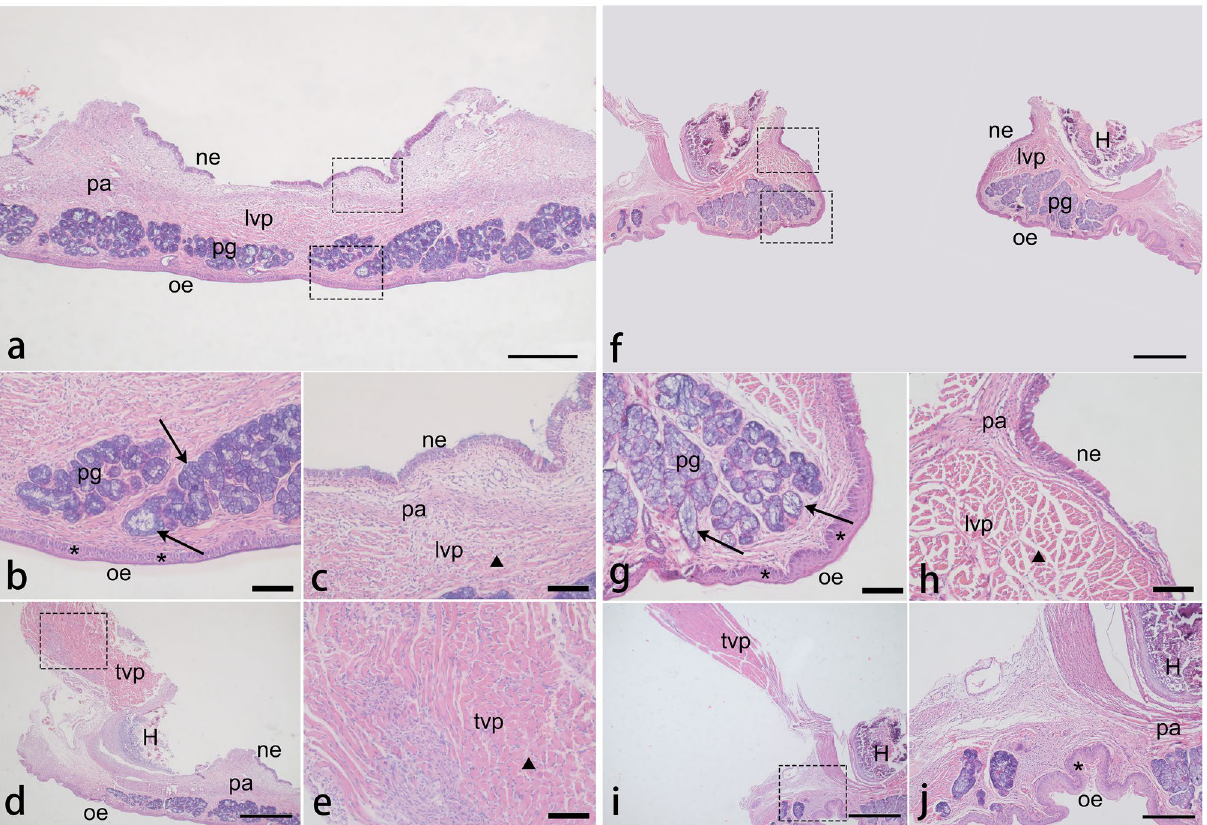
Figure 5. Histology view of the coronal sections of the palate in the control ( a – e ) and the cleft ( f–j ). Paraffin sections were cut at the level of the pterygoid hamulus (H) and stained with H&E. The soft palate stratigraphy can be seen, from the mesial side ( a , f ) to the distal side ( d , i ), from the nasal side (top) to the oral side (bottom). ( b , g , j ) The asterisk represents a thin stratified squamous epithelium in the control and a thickened stratum corneum in the oral epithelium of the cleft. What the arrow shows reconfirm the differences of the type and morphology of the palatal gland between the two groups. ( c , h , e ) The triangle shows the morphology of palatal muscle tissues in two groups and reconfirms the looser muscle bundle arrangement in the cleft. The levator veli palatini fibers in the control crossed the midline forming a muscle sling, while muscle bundles in the cleft present a cross-section morphology indicating that the levator veli palatini ran parallel to the edge of the cleft. The palatine aponeurosis can be seen, lying under the nasal epithelium, a pseudostratified ciliated columnar epithelium. ( d , i , j ) The tensor veli palatini muscle in both groups diffused into the palatine aponeurosis medially and anteriorly at the pterygoid hamulus. ne nasal epithelium, oe oral epithelium, pa